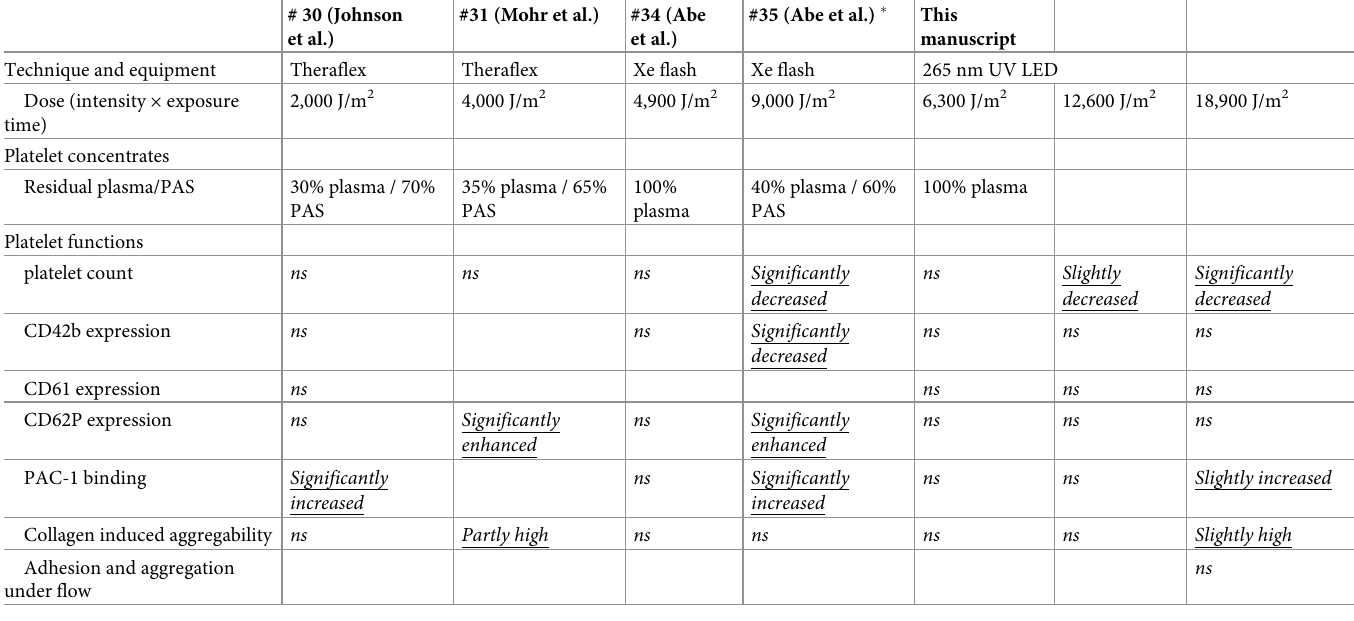
Table 3. Effect of UV irradiation techniques on platelets functions. Data extrapolated from reports. # 30 (Johnson et